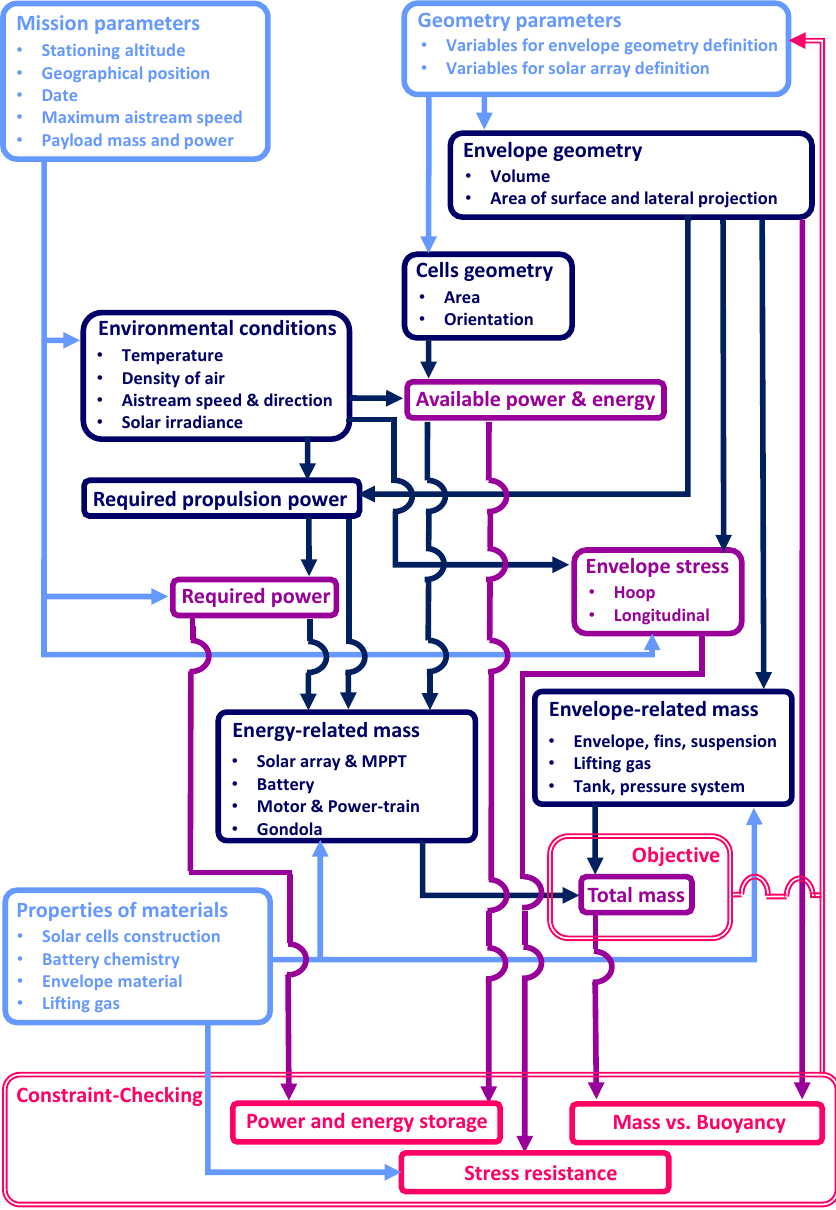
Figure 2. Workflow of the sizing loop and optimization